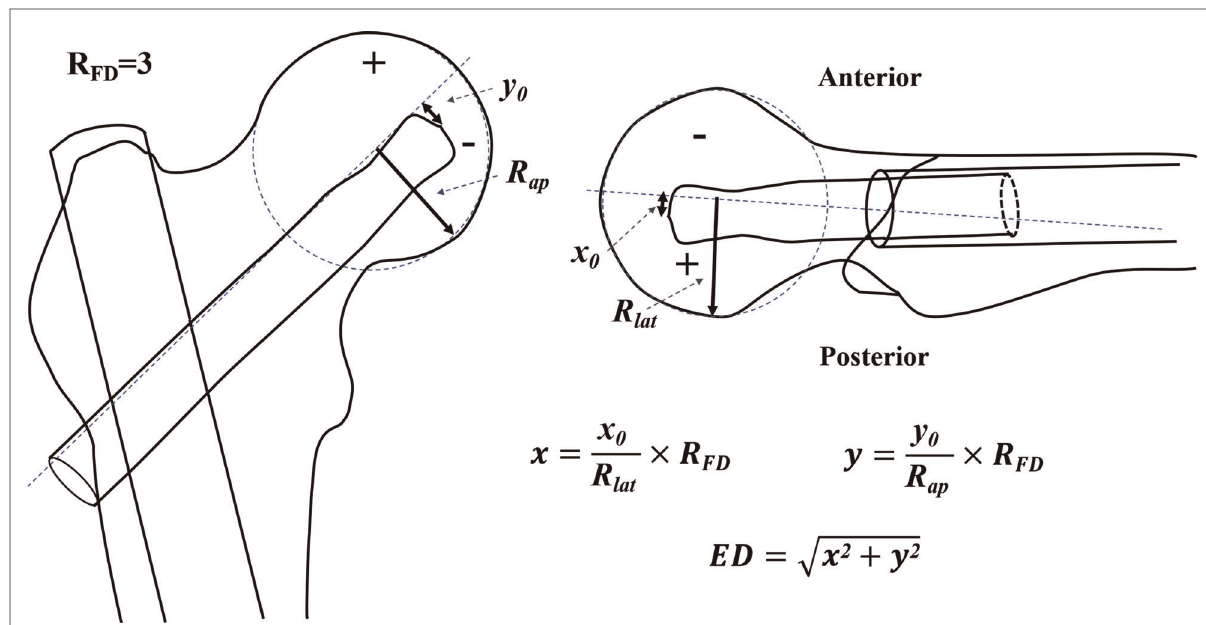
FIGURE 1 The measurement and calculation of ED based on our previous study (23). No matter how big the radius of the femoral head ( R FD ) was, we standardized the R FD as “ 3 ” ( R FD = “ 3, ” without any unit) for a good match with the Cleveland zone system and easy calculation. “ x 0 , y 0 , R ap , R lat ” were the actual measured values. The ED of the cephalic fi xators was calculated by the distances from the cephalic fi xator tip to the geometric central axis in the femoral neck and head on both the AP view radiograph ( y=y 0 /R ap × R FD ) and the lateral view radiograph ( x=x 0 /R lat × R FD ) resulted in ED=( x 2 + y 2 ) 1/2 . The value of “ x ” or “ y ” was de fi ned as positive if the cephalic fi xator tip was on the superior or posterior, and as negative if the cephalic fi xator tip was on the inferior or anterior when compared with the axis of femoral head. ED, eccentric